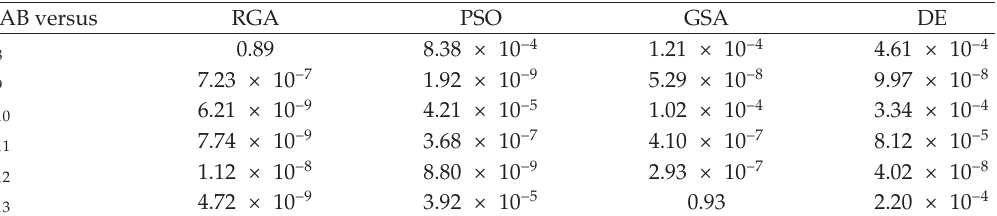
Table 6: P values produced by Wilcoxon’s test comparing CAB versus RGA, PSO, GSA, and DE over the “average best-so-far” values from Table 5.